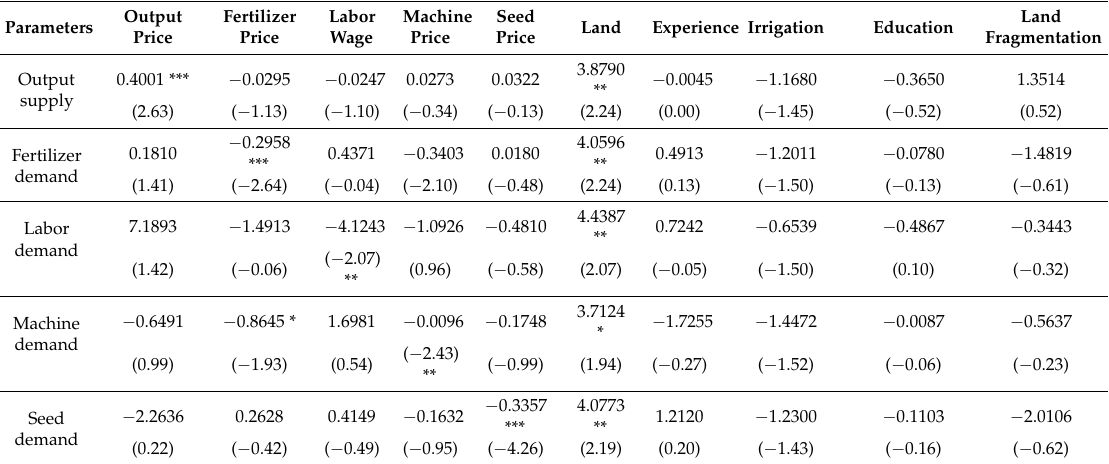
Table 6. Estimated elasticities of the translog profit function of